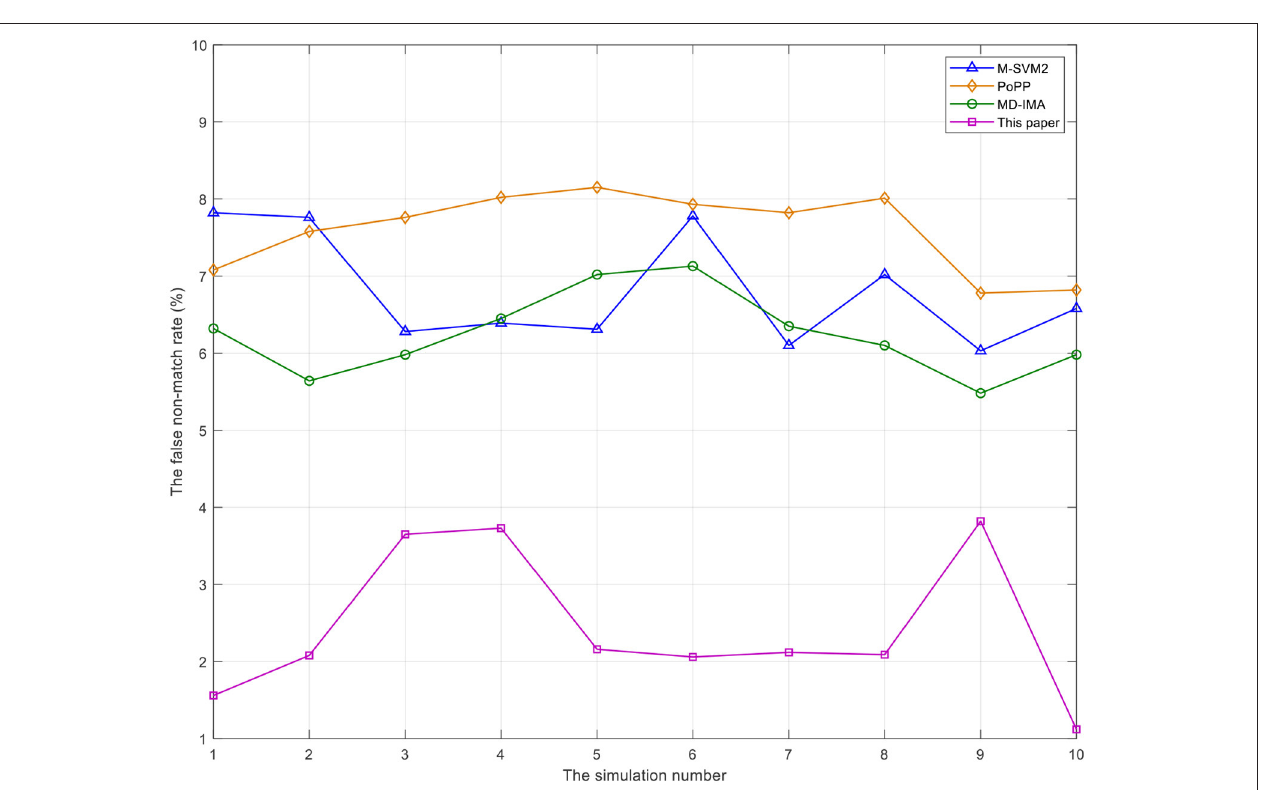
FIGURE 4 | The comparison of false non-match rate of mental state recognition of undergraduates in medical college by different methods.